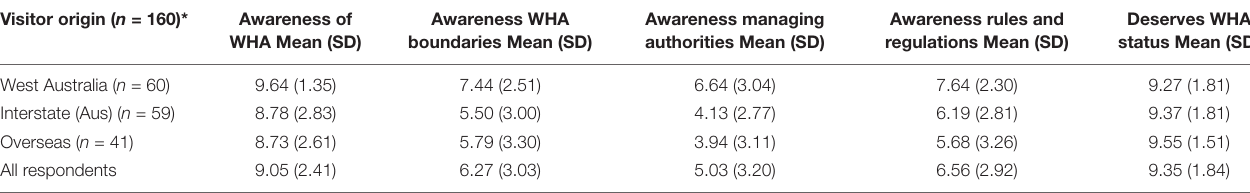
Scores are based on a Likert scale between 1 (representing strongly disagreed) and 10 (representing strongly agreed). *Three respondents did not identify their origin.